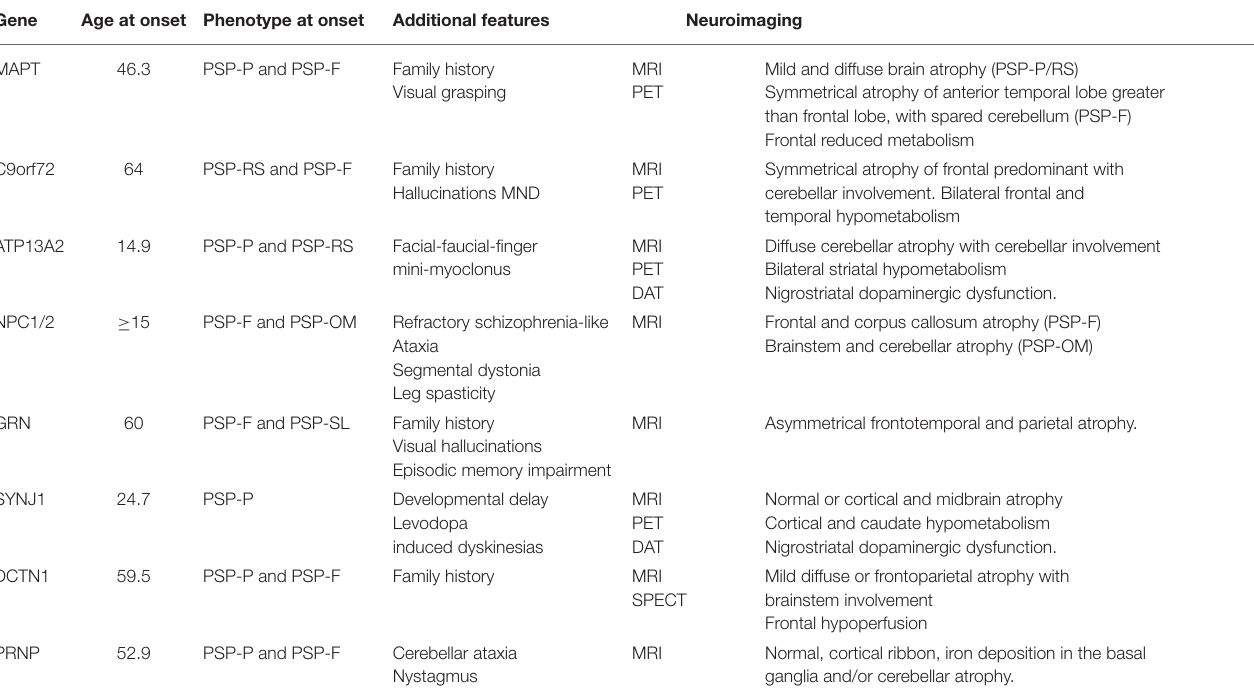
TABLE 1 | Genes commonly associated with PSP phenotype of monogenic origin. Gene Age at onset Phenotype at onset